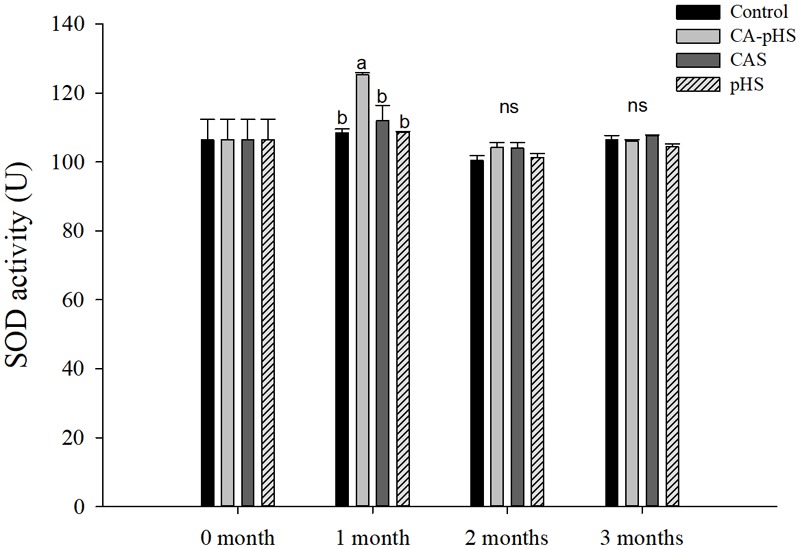
Juvenile of S. constricta superoxide dismutase (SOD) activity levels in the long-term toxicity test. Bars (mean ± SE, n = 3) with different letters denote significant differences (p < 0.05) among the four groups in each month. The letters “ns” indicate insignificant difference among the four groups in each month.